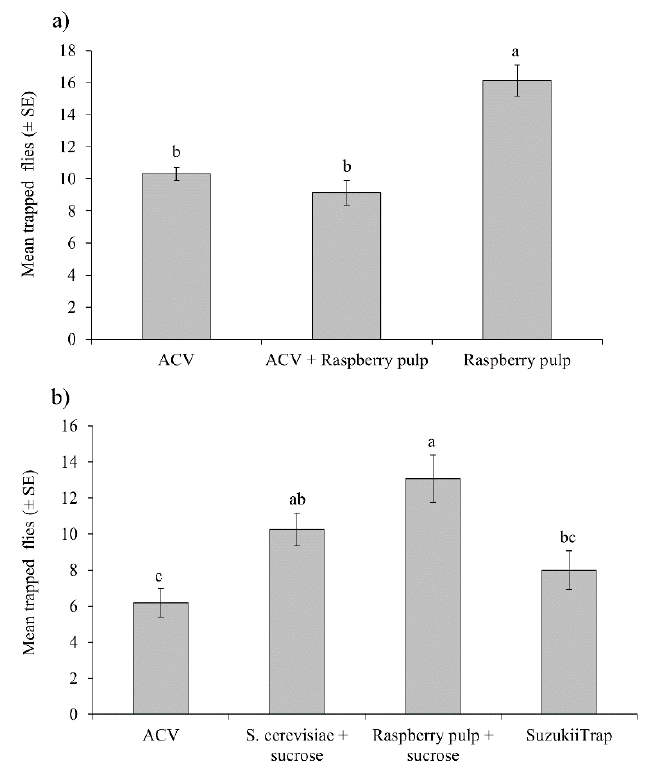
Figure 3. Mean numbers of D. suzukii (males and females) trapped in di ff erent treatments in two independent experiments: ( a ) comparison of raspberry pulp and ACV, and ( b ) comparison of ACV, baker’s yeast + sucrose, raspberry pulp + sucrose, or the commercial product SuzukiiTrap. Columns labelled with the same letter did not di ff er significantly (Tukey, p > 0.05).